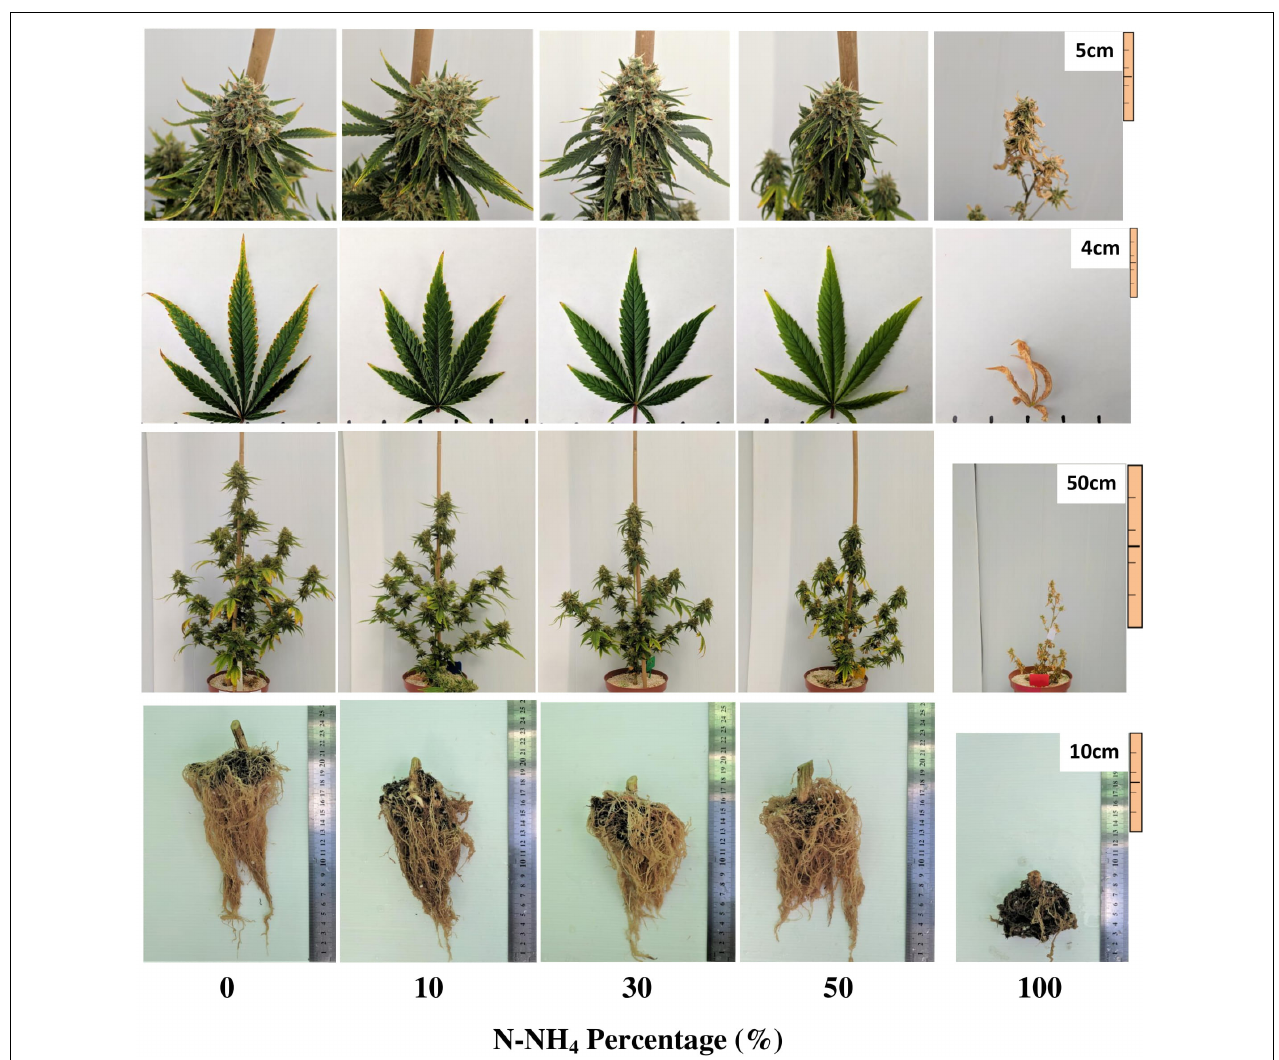
FIGURE 1 | Visual appearance of the inflorescences, leaves, whole plants, and roots under increasing N-NH 4 supply. The inflorescence images are of the apical inflorescence on the main stem, and leaf images are of the youngest, fully developed leaf located on the third branch from the plant’s top. Inflorescence, whole plant and root images were taken at maturation (harvest), leaf images were taken 10 days earlier. The brown substance at the base of the roots is a remnant of the coconut fiber plug used for rooting the cuttings at the propagation of the